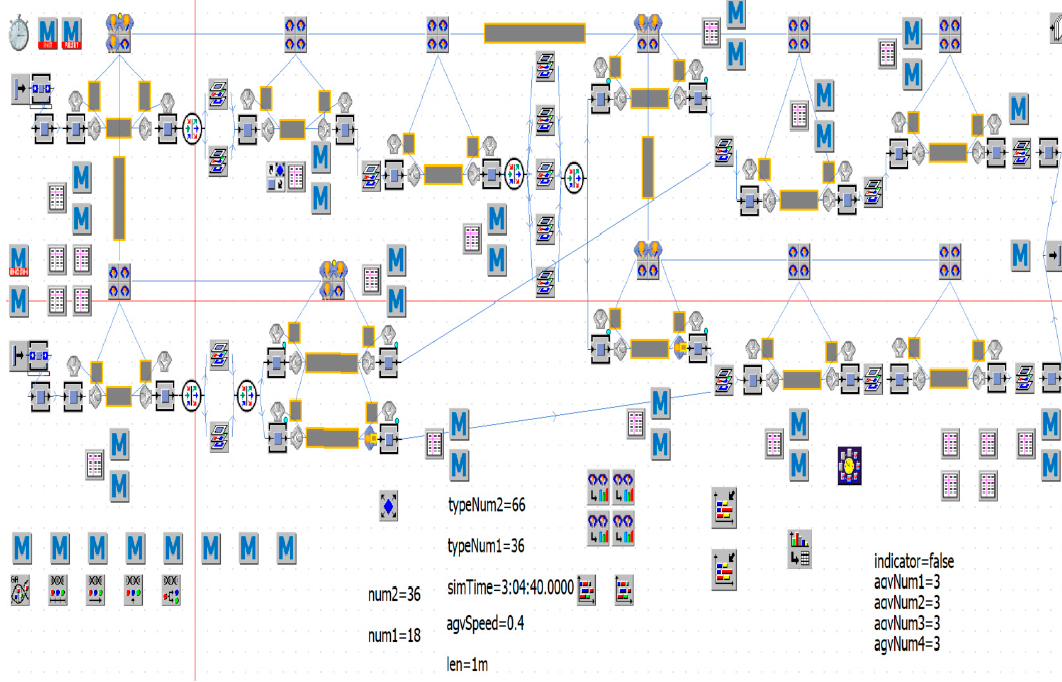
Figure 8. Execution of the simulation.